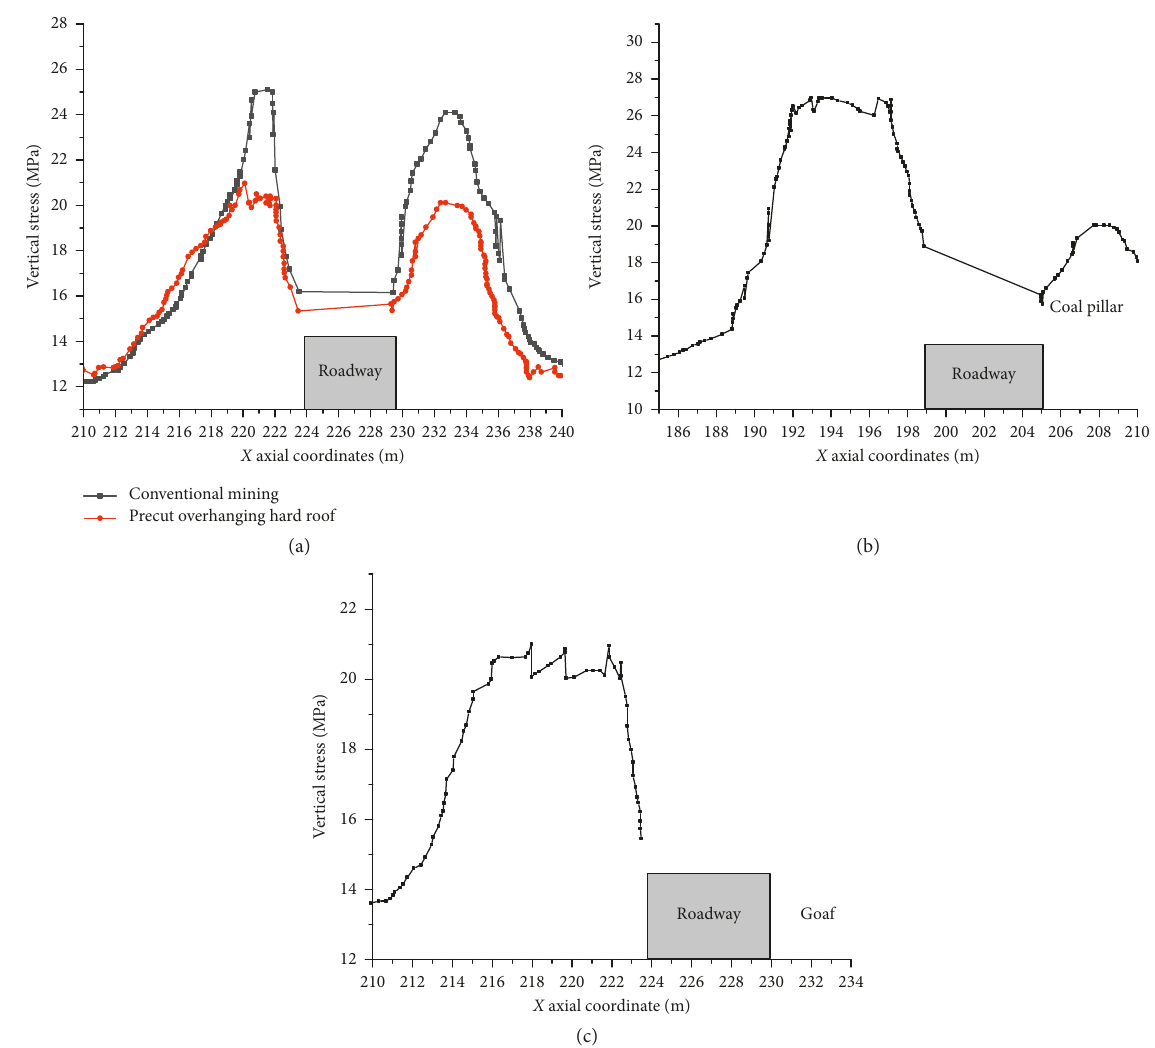
Figure 7: Distribution of stress around roadway. (a) Excavate upper working face. (b) Excavate second working face by conventional mining. (c) Excavate second working face by precut overhanging hard roof